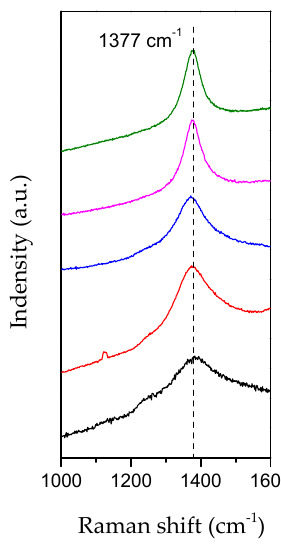
Figure 4. Raman spectra recorded on samples TiBN800 ( black ) to TiBN1200 ( green ).